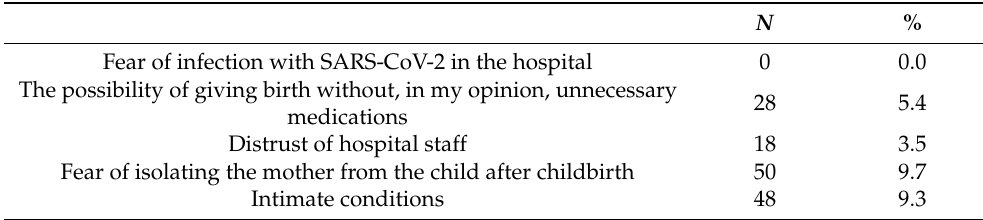
Table 3. The frequency analysis results in the answer to the question, “If you considered giving birth at home, what factors impact your decision?”.